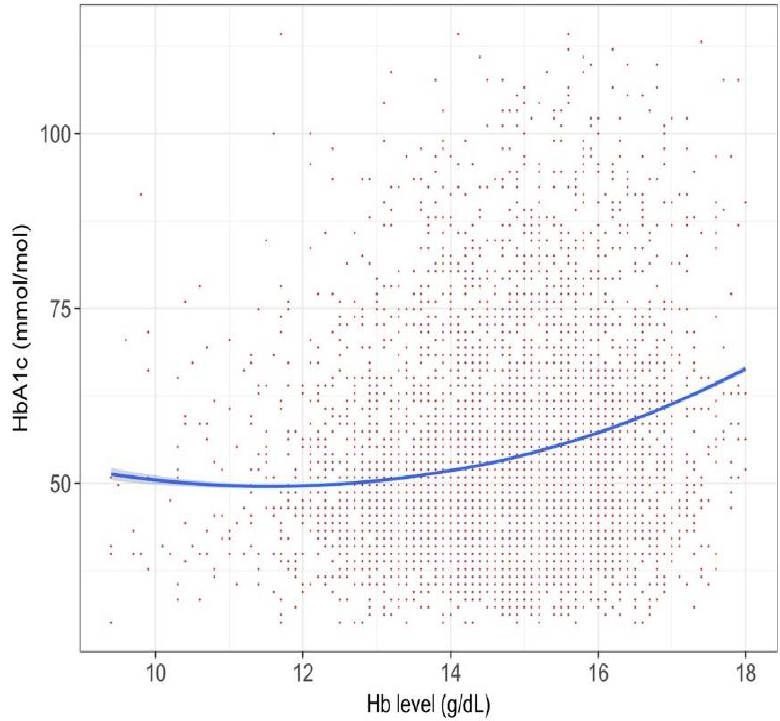
Figure 4. The relationship between Hb and HbA 1c values in persons with glucose-lowering medication prescription, within 90 days of their health checkup ( n = 6253).